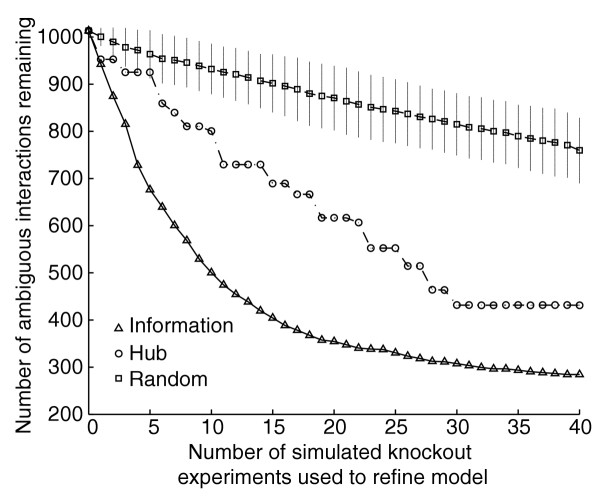
Simulated learning curves of three experimental design methods. Three different methods of selecting experiments are compared: mutual information scores (triangles), hub selection (circles), and random selection (squares). We performed 100 simulated trials and show the average number of ambiguous interactions remaining in the inferred model after each simulated knockout experiment. Vertical bars indicate the standard deviations for the random selection method. The standard deviations for the information and hub selection curves are less than five and are not shown for clarity.